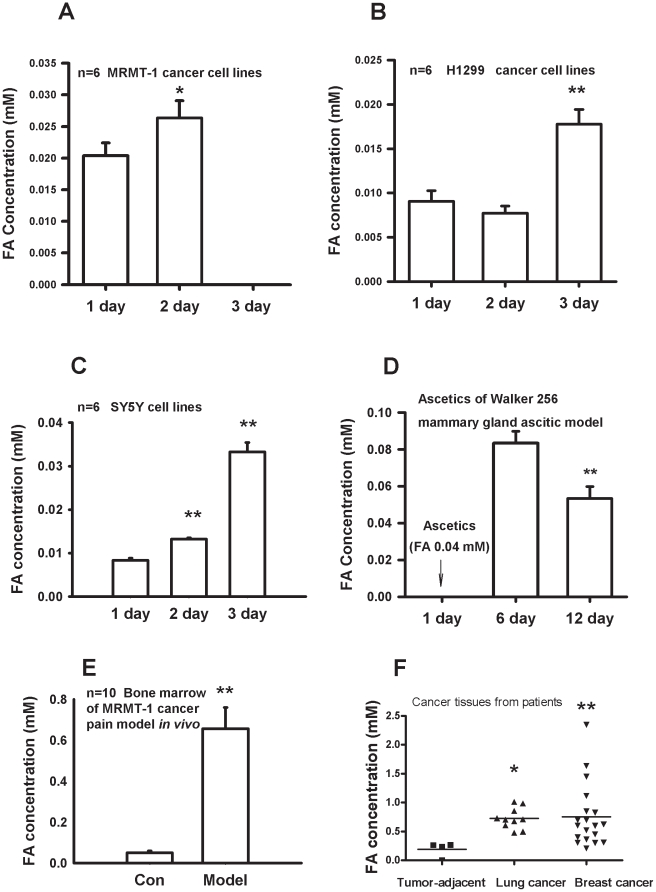
Formaldehyde concentration in the cultured cancer cell lines in vitro and in vivo.(A) MRMT-1 cancer cells. (B) Human H1299 lung cancer cells. (C) Human SY5Y cancer cells. (D) Ascites from peritoneal inoculation of Walker 256 mammary gland carcinoma cells. (E) Bone morrow of MRMT-1 breast cancer pain model rat in vivo. (F) Tumor tissues from lung and beast cancer patients. * p<0.05, **
p<0.01, compared with that of the first day.